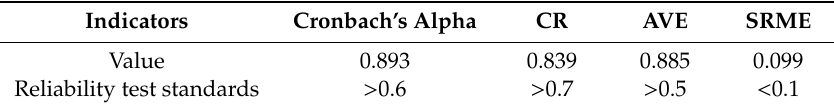
Table 5. Model fit test results